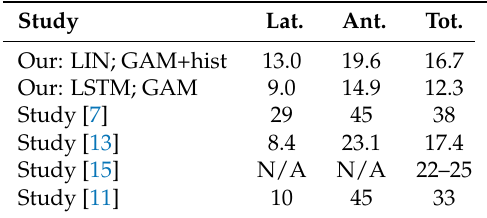
Table 5. Comparison of our COP RMS error [mm] results and results from References [7,11,13,15]. N/A - not available, Reference [15] does not report values for COP RMS errors for anterior and lateral direction. Results are shown for lateral (Lat.), anterior (Ant.) and total (Tot.) COP RMS error. Study Lat. Ant.